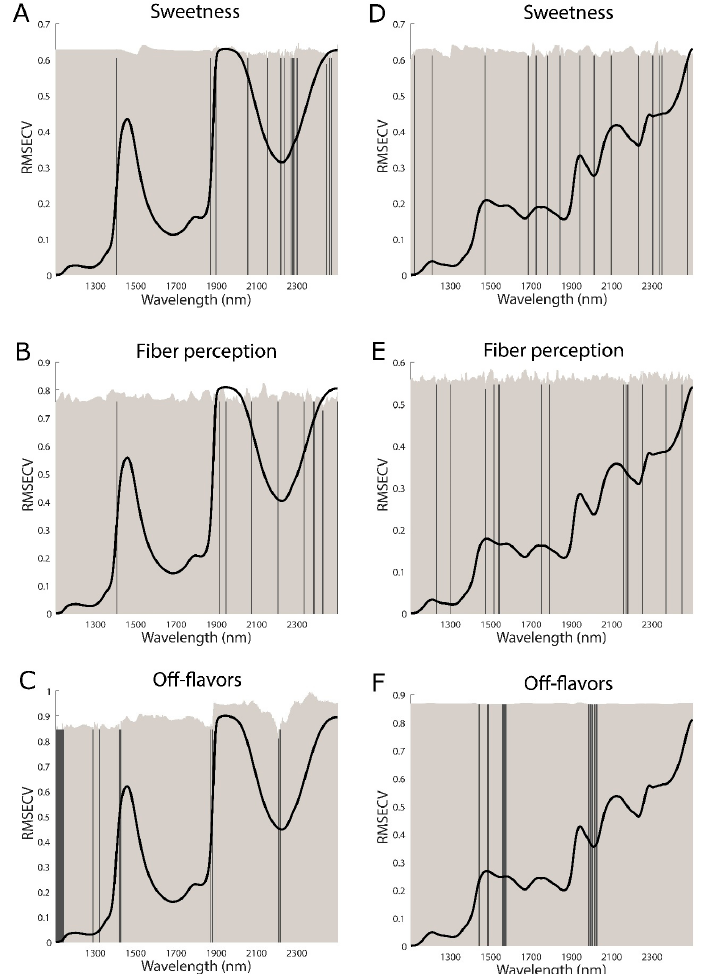
Figure 2. The optimal combination (low RMSECV) of spectral intervals determined by iPLS variable selection (dark gray) for puree ( A – C ) and ground dried puree ( D – F ).